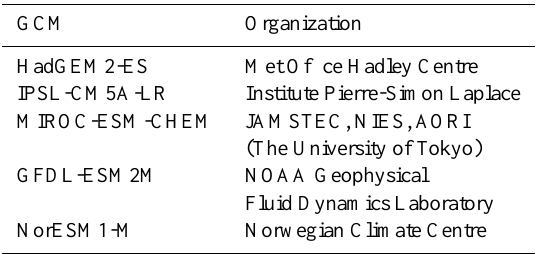
Table 1. GCMs (global climate models) used in this study. Table 2. Overview of representative concentration pathways